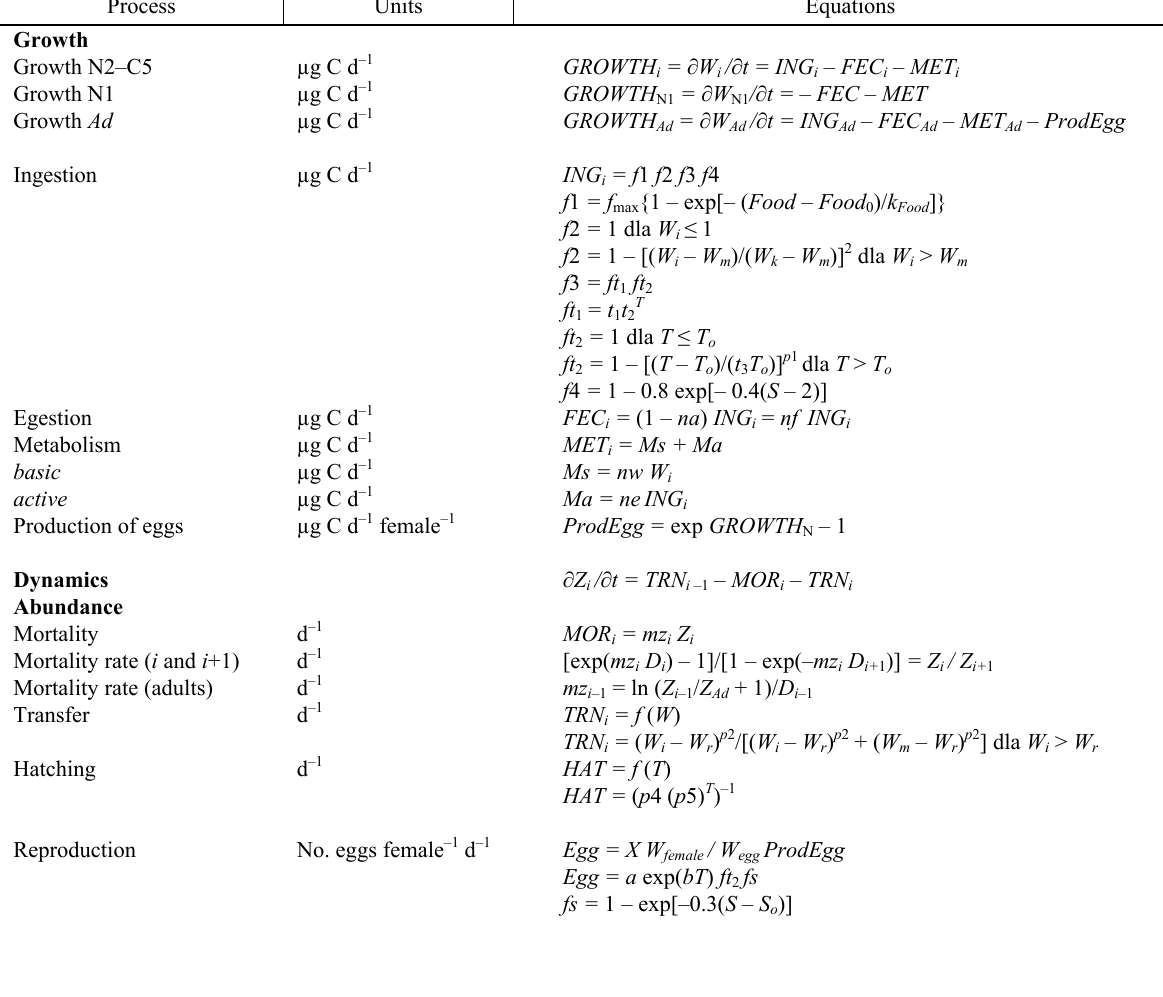
Table 1. Mathematical relationships used in the model; i , stages; Food , food concentration; T , temperature; W i , mass; W k ,